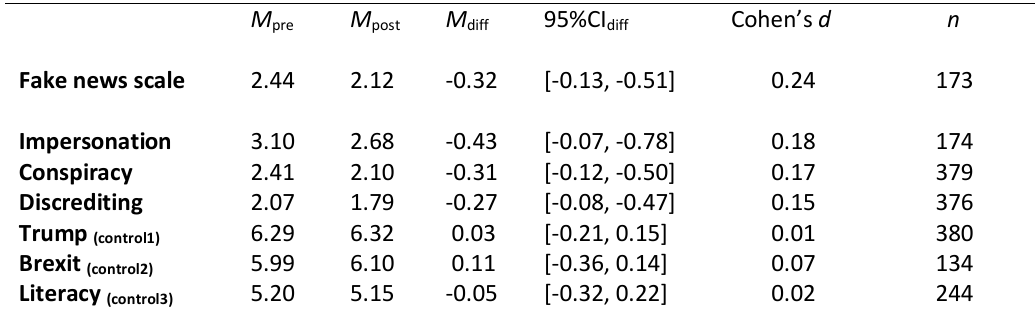
Table 3. Average reliability (pre-post) judgments overall and for each fake news badge by country (Sweden).